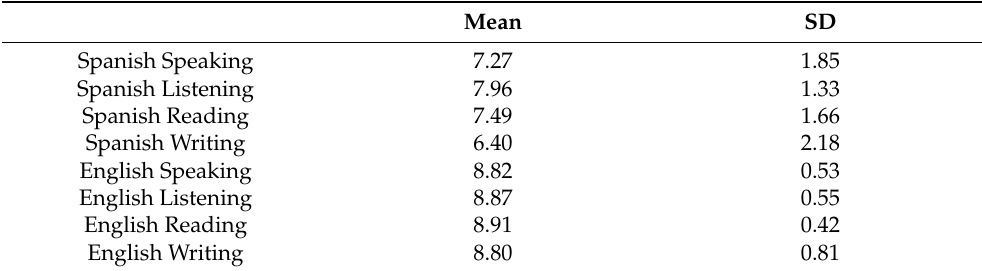
Table A3. Intelligibility study listeners